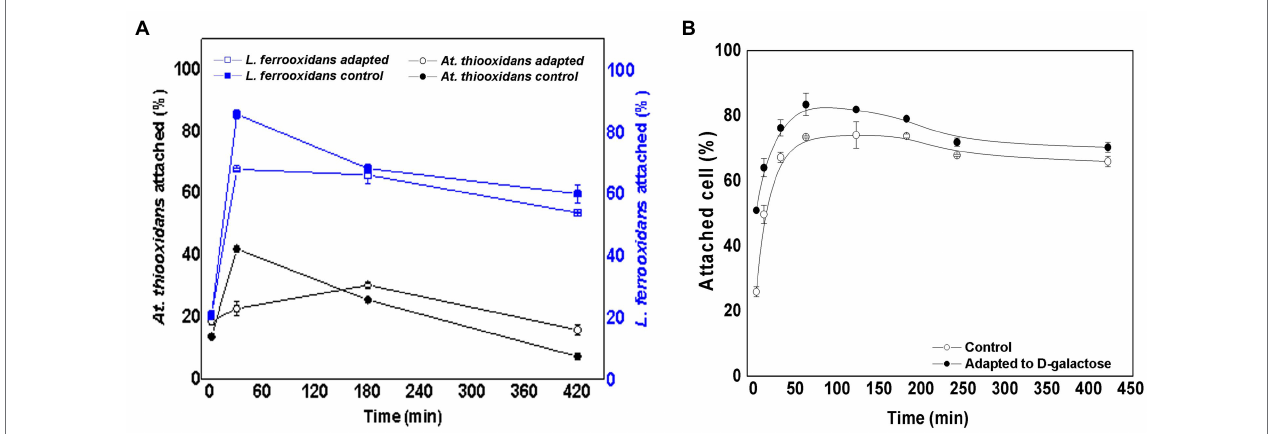
FIGURE 4 | Attachment percentage to the mineral over time for the consortium in proportion of 30:70 of At. thiooxidans DSM 14887 T and L. ferrooxidans DSM 2705 T , respectively. (A) Data obtained by qPCR. (B) Data obtained by counting of total planktonic cells using a Neubauer chamber. The data correspond to the mean values of triplicates ± SD ( n =